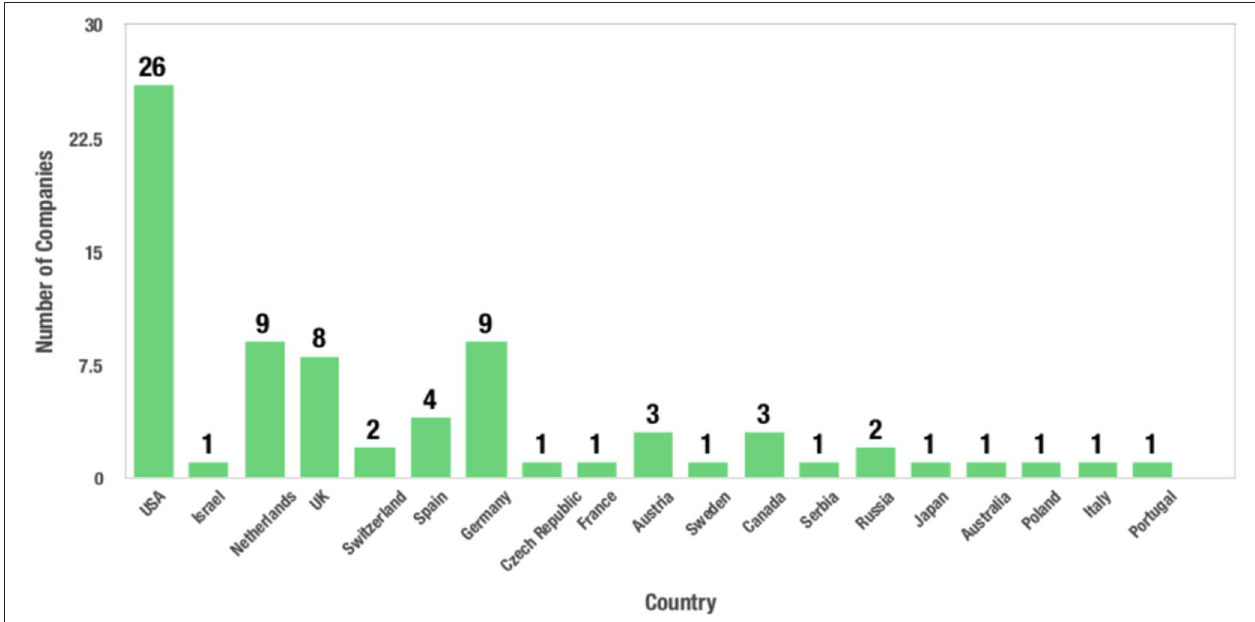
FIGURE 4 | Distribution of BCI companies around the